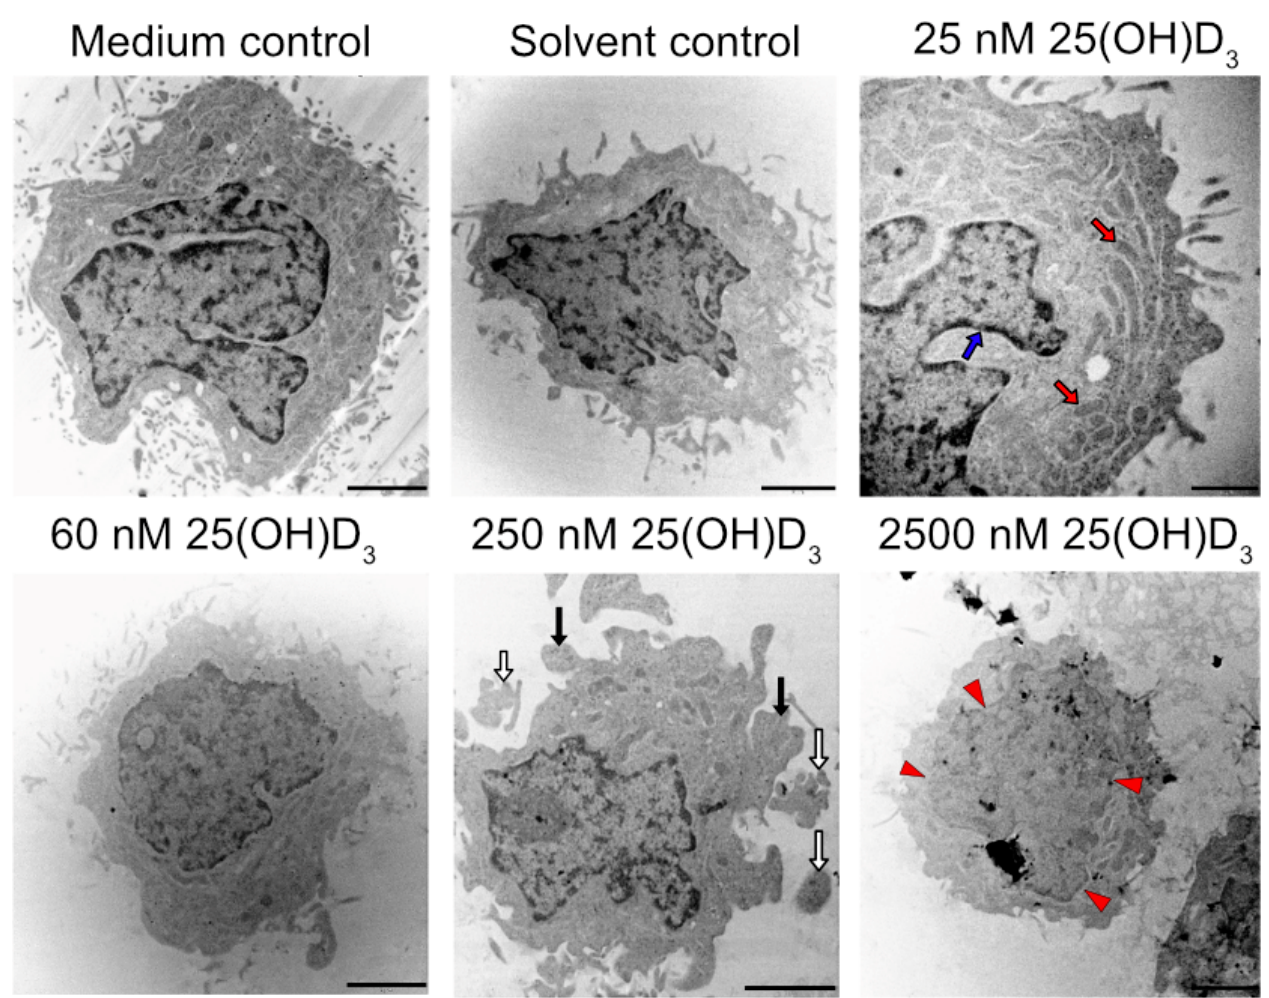
Figure 6. Ultrastructural analysis of SiHa control and experimental cultures analysed by TEM. Cell rounding and membrane blebbing (black arrows), apoptotic body formation (white arrows), and nuclear damage (karyolysis, red arrowheads). Red arrows indicate healthy mitochondria, and an intact nuclear membrane is indicated by blue arrows (scale bar = 1 µm).